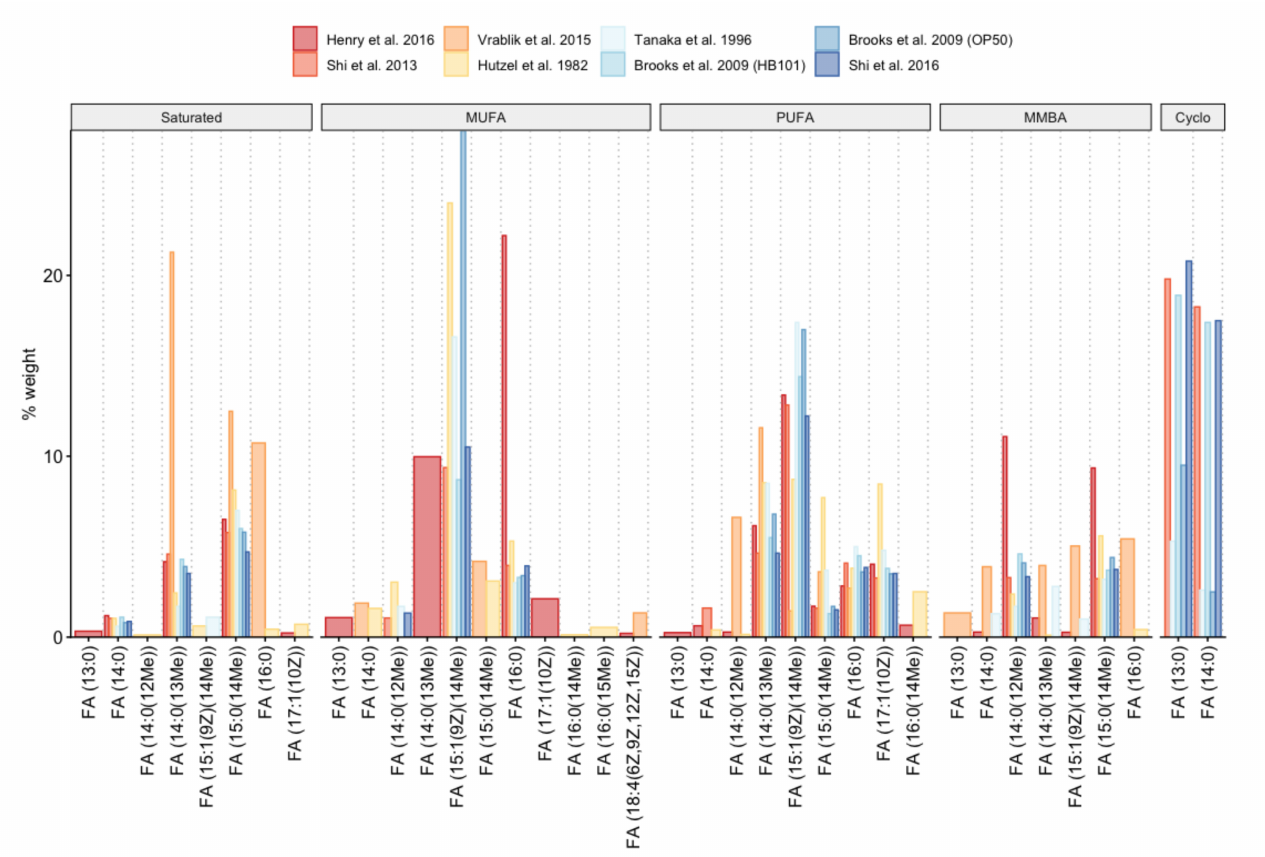
Figure 2. FA profiles from different publications. From left to right: saturated, monounsaturated (MUFA), polyunsaturated (PUFA), monomethyl branched chain (MMBA), and Cyclopropane (Cyclo) fatty acids. Publications that were included: Henry et al., 2016 [75], Shi et al., 2013 [90], Vrablik et al., 2015 [93], Hutzel et al., 1982 [125], Tanaka et al., 1996 [126], Brooks et al., 2009 (HB101 & OP50) [127], and Shi et al., 2016